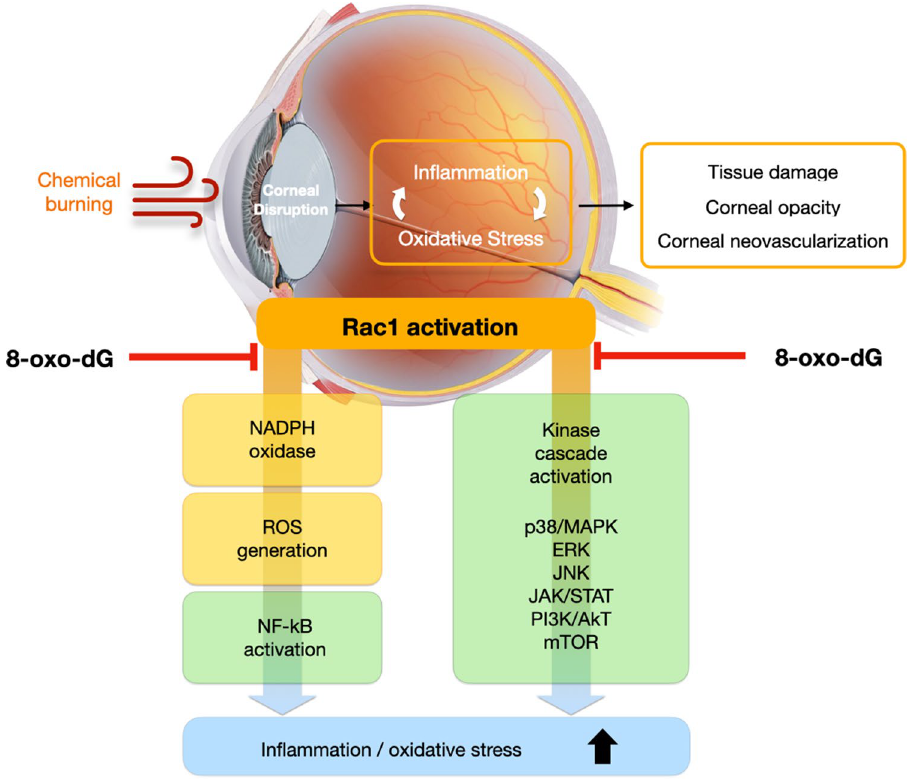
Figure 8. Putative anti-inflammatory mechanism of 8-oxo-2 ′